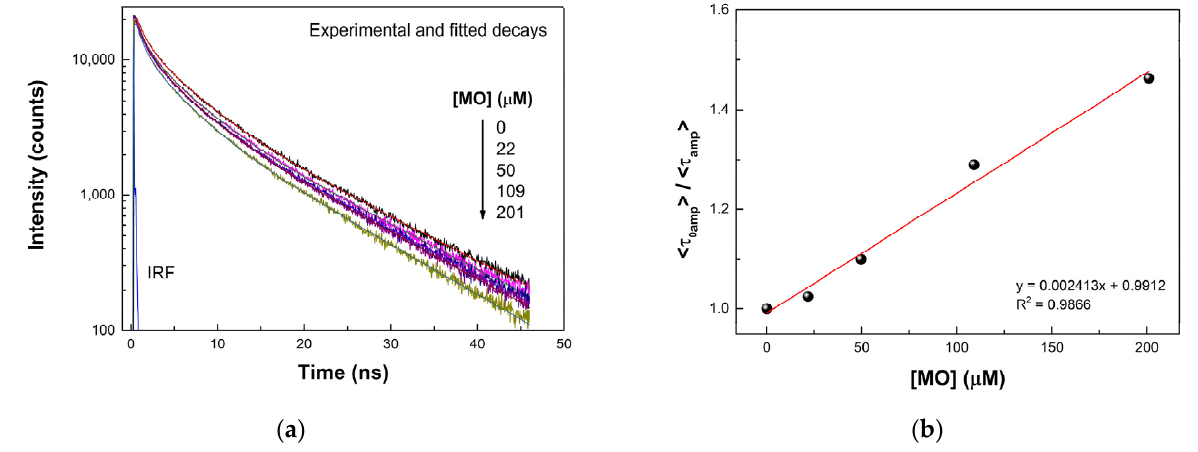
Figure 8. ( a ) Time-resolved intensity decays (excitation at 340 nm; observation at 426 nm) of WP-CDs (0.1 mg/mL) upon addition of MO in aqueous solution. ( b ) Stern-Volmer plot of the amplitude average lifetimes of WP-CDs in the absence and presence of increasing concentrations of the dye.